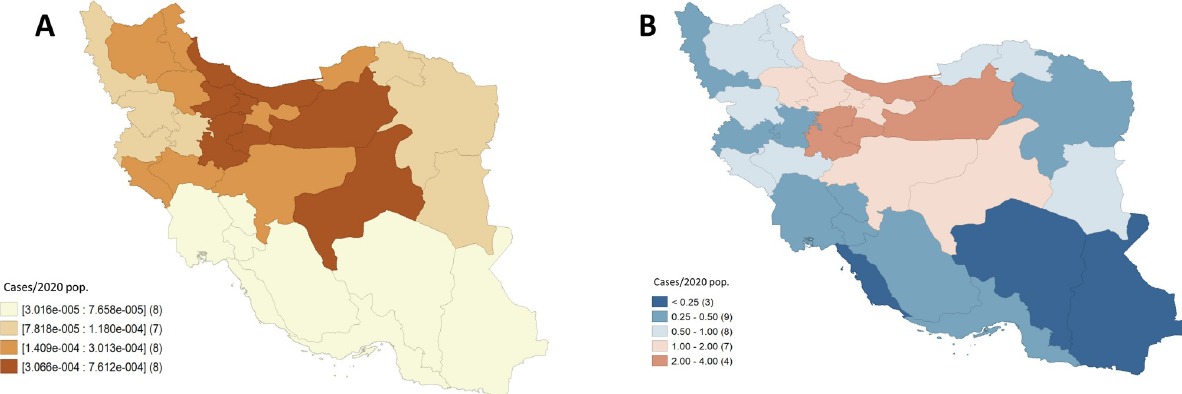
Fig 1. Maps associated with COVID-19 cases by province from February 19th to March 20th, 2020. A) Quartiles corresponding to rates smoothed through an empirical Bayes procedure. B) Excess or relative risk. Shapefiles obtained from the Stanford Libraries Earthworks: